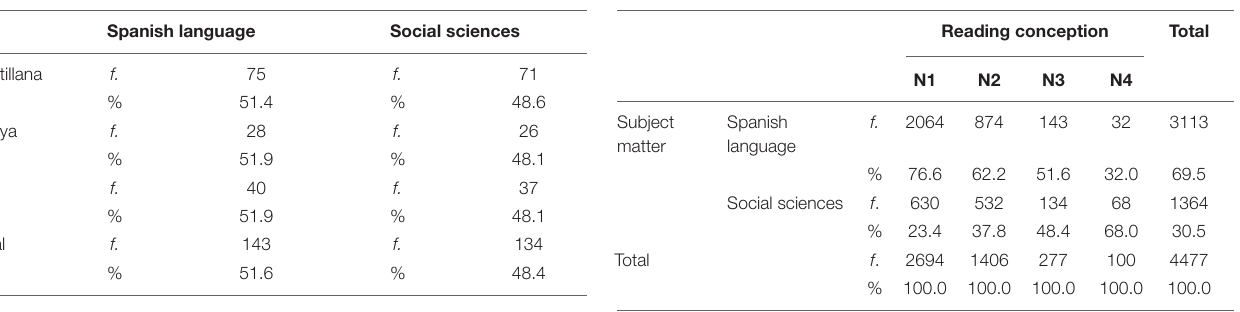
TABLE 7 | Contingency table for the variables subject matter and reading conception.